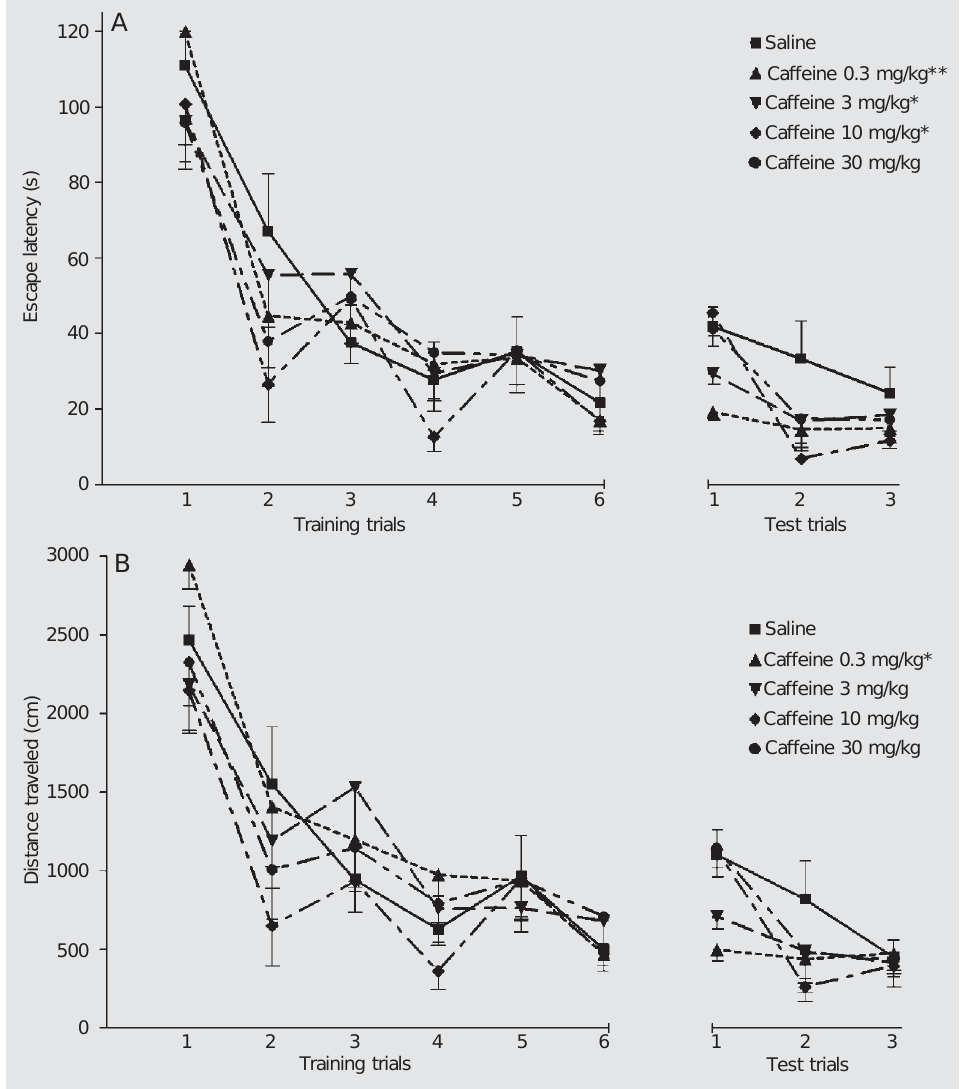
Figure 3. Effect of the adminis- tration of caffeine immediately after the training session on the learning of the Morris water maze task. The results are re- ported as mean latency (A) or distance (B) the animals traveled from the starting point to the submersed platform. The test tri- als were performed 48 h after the training trials. The X-axis rep- resents the starting position for each trial. *P (cid:1) 0.05 and **P (cid:1) 0.01 compared to control (Duncan test after two-way ANOVA re- lated to test